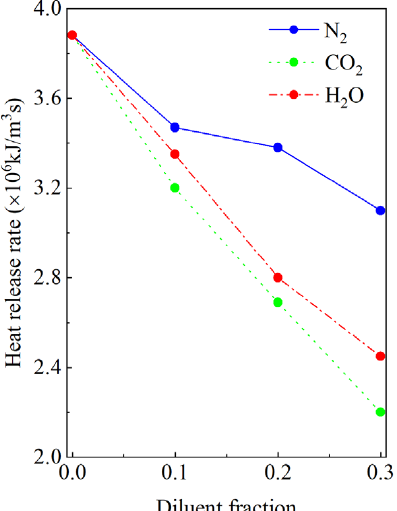
Figure 5. Variation in the HRR with the diluent fractions.